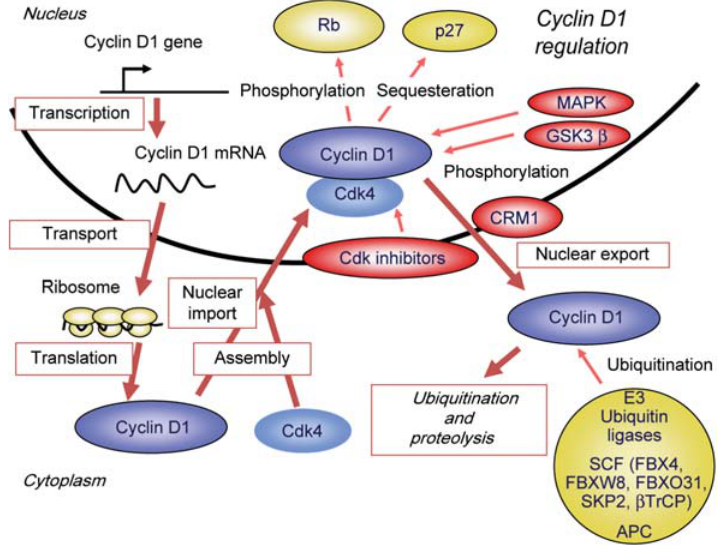
Figure 1 Overview of the regulation of cyclin D1.